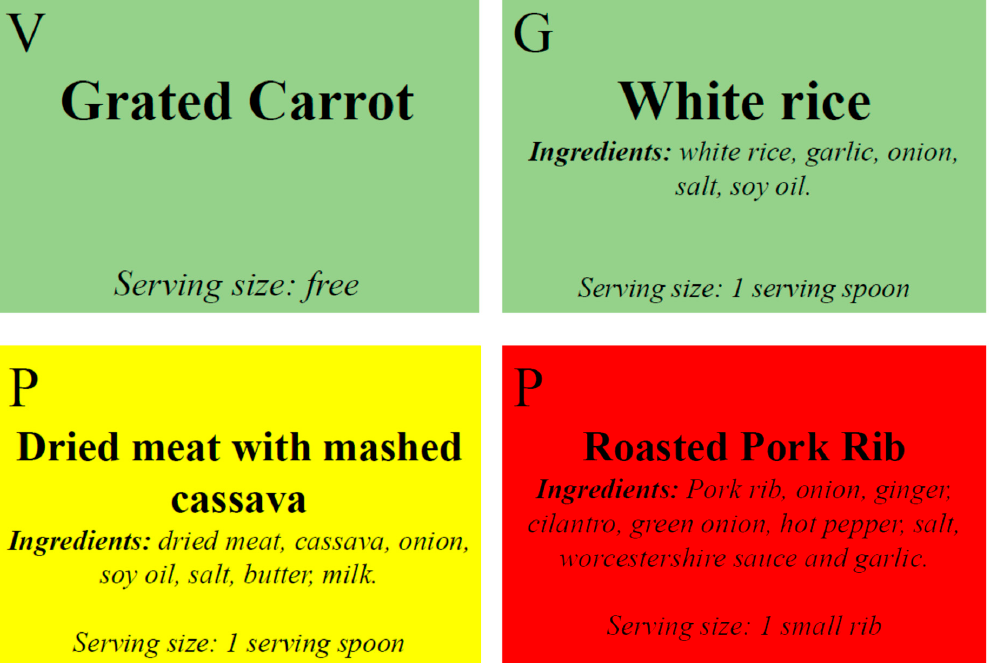
Figure 1. Examples of food nameplates proposed to the restaurant by using the rating scale. V = Vegetable; G = grains; P = Protein. V = Vegetable; G = grains; P =